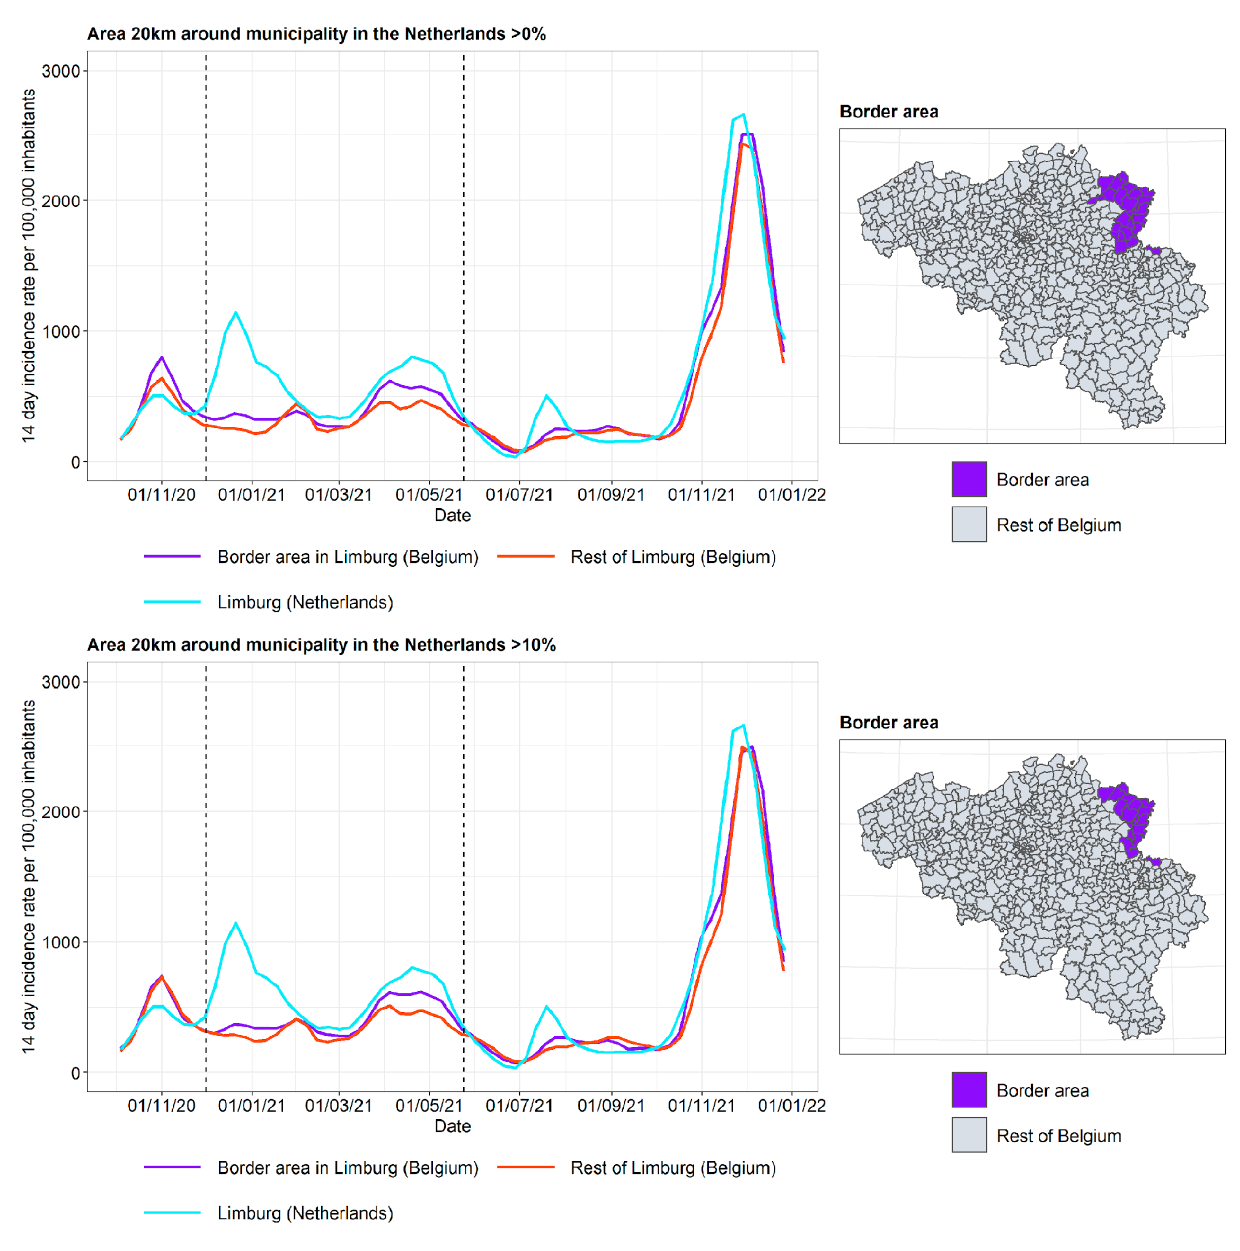
Figure 8. COVID-19 incidence curves for the border area of Limburg (Belgium) and Limburg (The Netherlands). Selected period for the summary measures in Figure 10 is denoted by vertical dashed lines.